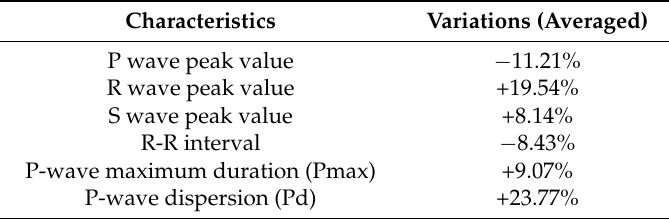
Table 1. The variations of ECG characteristics between normal cases and drunk